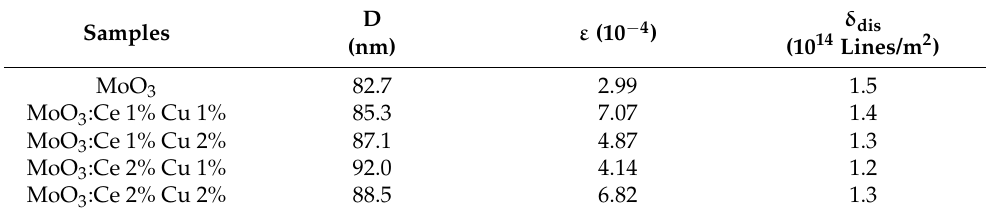
Table 2. Crystallite size D, the microstrain 𝜀 and dislocation density δ dis for MoO 3 thin films grown for different contents of Ce and Cu in the spray solution. Samples